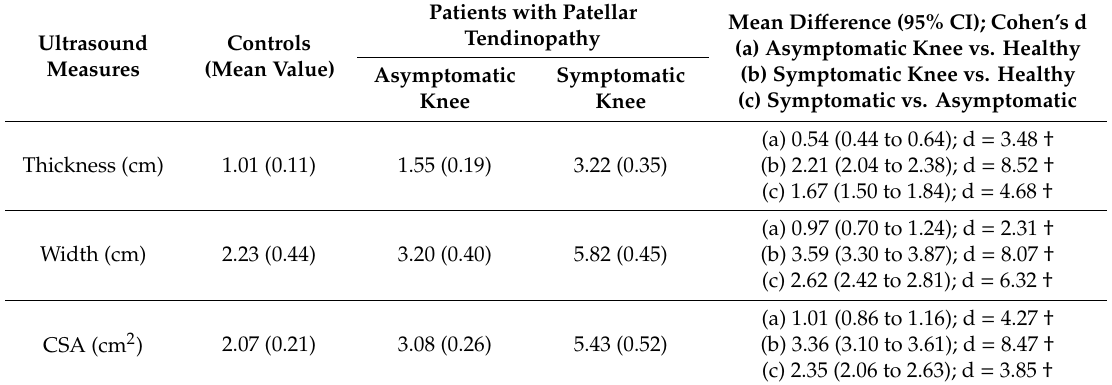
Table 3. Descriptive data (mean (SD)) and multiple comparisons for ultrasound measurements between patients with patellar tendinopathy and control subjects.